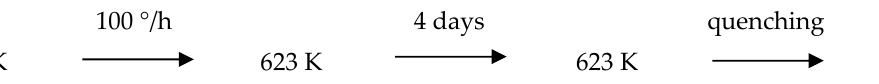
Figure 1. Schematic drawing of the experimental process. Yellow squares represent thallium(I) salts, gray circles represent sodium, white squares represent sodium(I) salts, and black circles represent NaTl. Once the solution had turned colorless, the ammonia was poured through the frit into the second leg and condensed back onto the reactants, this procedure was repeated three